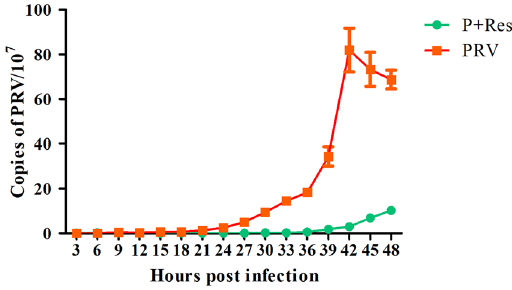
Figure 2. Growth curves of PRV in PK-15 cells in the presence or absence of Res. PK-15 cells were infected with PRV at an MOI of 0.01 and test Res (65.72 μ M) solution for 1 h at 37 °C. PRV proliferated in the PK-15 cells in the presence or absence of Res within 48 h. The total DNA was extracted at the indicated time points, and copies of PRV were detected via real-time FQ-PCR. Values are means ± SD (n = 3).